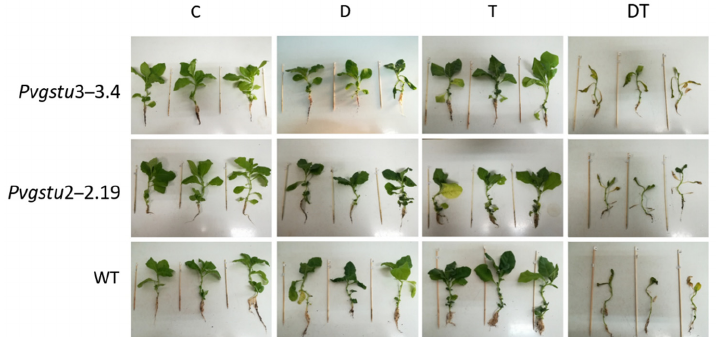
Figure 1. Effect of heat (T), drought (D) and combination of drought and heat (DT) stress on the growth of transgenic lines ( Pvgstu3–3.4 and Pvgstu2–2.19 ) and wild-type (WT) tobacco plants after 9 days compared to the stress-free, control (C) conditions. It is interesting that under single D or T stresses did not show any significant wilting as compared to the DT treatment.